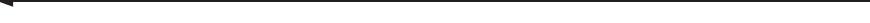
Figure 4: Nonlinear plasmonic scattering and resolution enhancement with gold